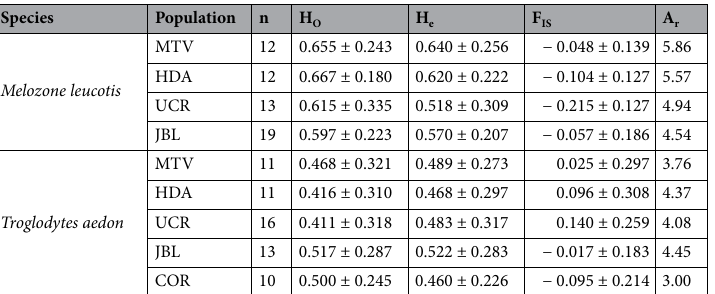
Table 1. Mean (± SD) observed heterozygosity (H O ), expected heterozygosity (H e ), inbreeding coefficient (F IS ) and allelic richness (A r ) for each population assessed for white-eared ground-sparrow ( Melozone leucotis ) and house wren ( Troglodytes aedon